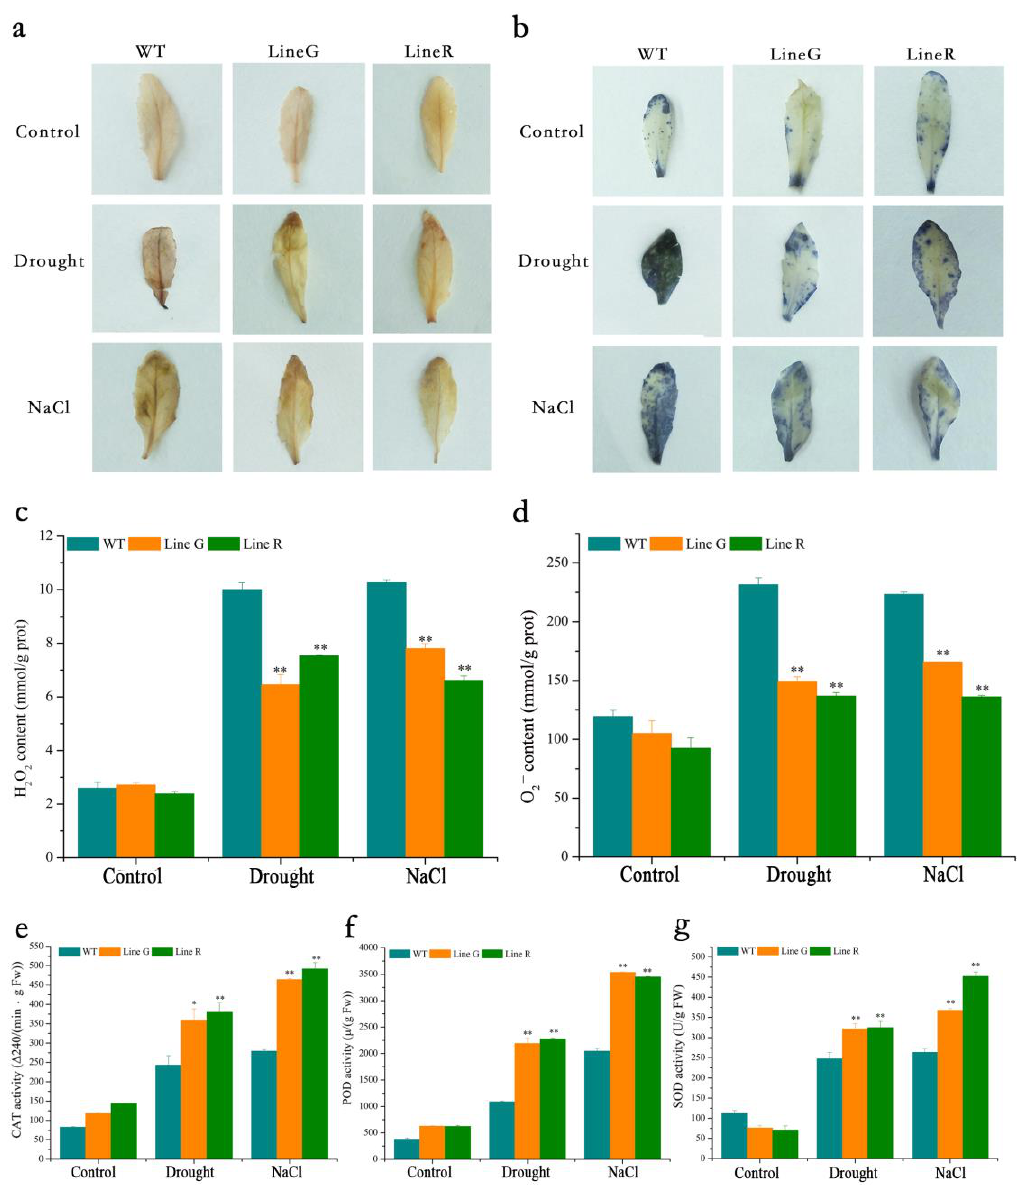
Figure 4. Analysis of reactive oxygen species (ROS) levels and antioxidant enzyme activities in MfPIF8 transgenic and WT Arabidopsis. ( a , b ) Indicates histochemical staining by 3,3 -diaminobenzidine (DAB) and nitroblue tetrazolium (NBT), respectively. ( c , d ) Quantitative assays of H 2 O 2 and O 2 − contents in MfPIF8 transgenic and WT Arabidopsis; ( e – g ) Indicates measurements of activities of antioxidant enzymes catalase (CAT), peroxidase (POD), and superoxide dismutase (SOD). Data are presented as mean and SD values of three independent experiments. Asterisks indicated significant difference (* p < 0.05, ** p < 0.01, by independent sample t -test) compared with WT.